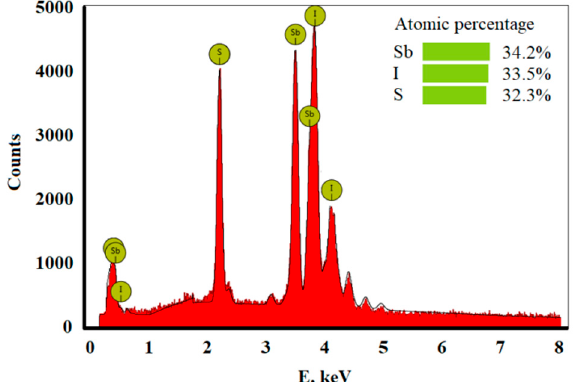
Figure 2. The energy-dispersive X-ray spectroscopy (EDS) spectrum of sonochemically prepared SbSI nanowires.